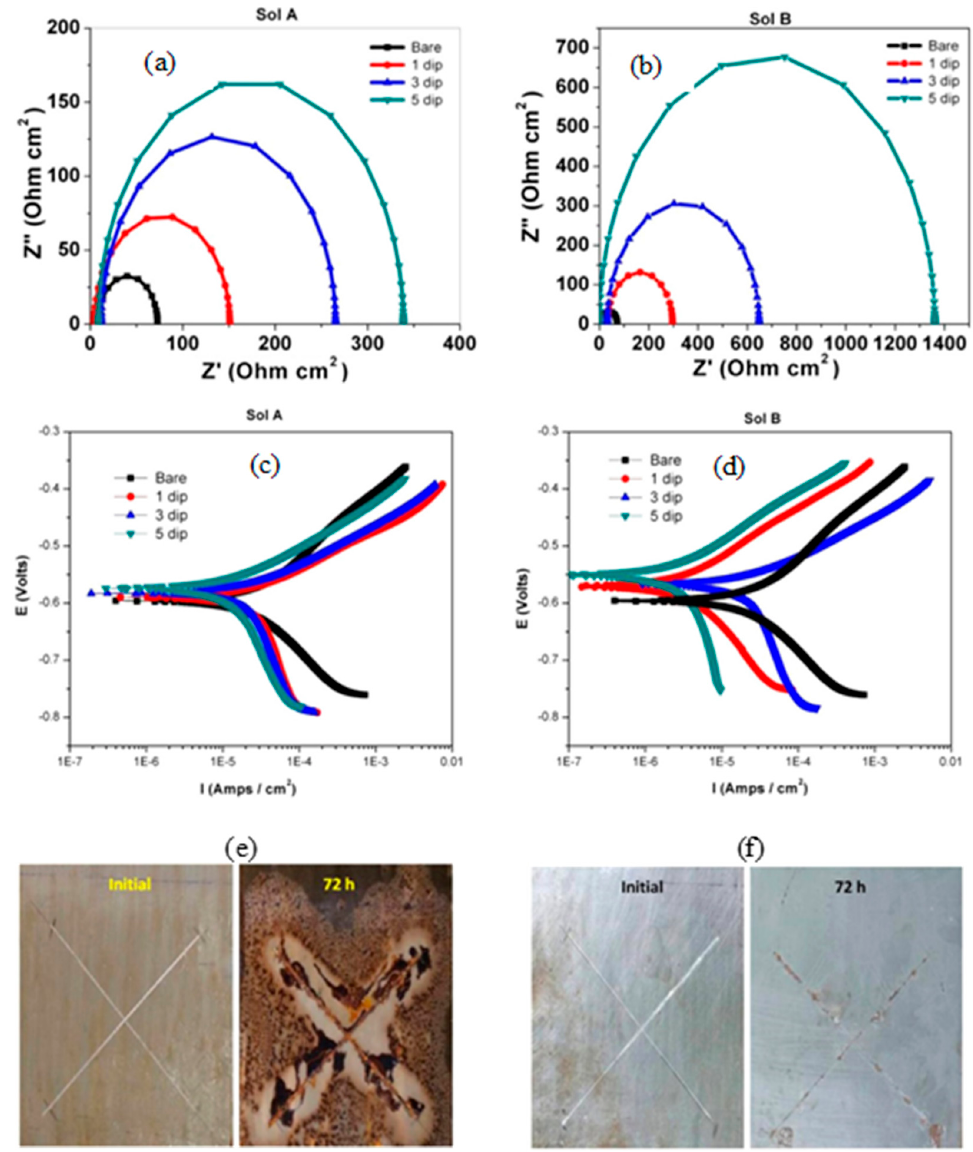
Figure 5. EIS plot ( a , b ) and Tafel plot ( c , d ) of sol-gel A and sol-gel B coating on mild steel in 3.5% NaCl solution. Salt spray testing of samples of sol-gel A and sol-gel B coatings on mild steel ( e , f ) [48]. Alibakhshi et al. [49] studied the effect of hydrolysis time and concentration of silane on the corrosion protection of mild steel; tetraethylorthosilicate (TEOS) and trimethoxymethyl- silane (TMOMS) were used as silane coatings. EIS results revealed that the coating of the mixture of 50% silanes (TEOS/TMOMS: 50/50 w / w ) hydrolyzed for 24 h provided greater corrosion resistance in 3.5% NaCl solution, due to the hydrophobic nature of the coating and better bonding with metal surface and formation of stable film as supported by SEM. The highest corrosion resistance was observed after 1 h of exposure, after which the resistance gradually dropped (as shown in Figure 6a), presumably due to the development of conductive pathways for the electrolyte diffusion through the coating. The phase angle values were more negative in the high-frequency regime for the silane coating with 24 h of hydrolysis compared to 48 h of hydrolysis, suggesting the better protection behavior of the former.